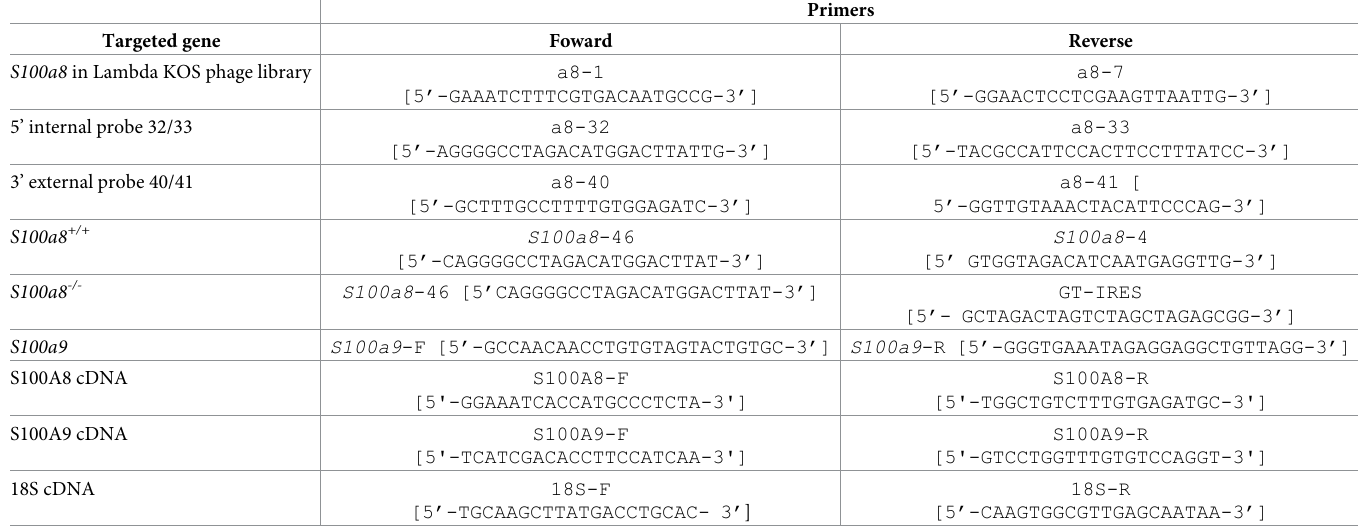
Table 1. PCR primers used for S100a8 -/- mice generation and mRNA